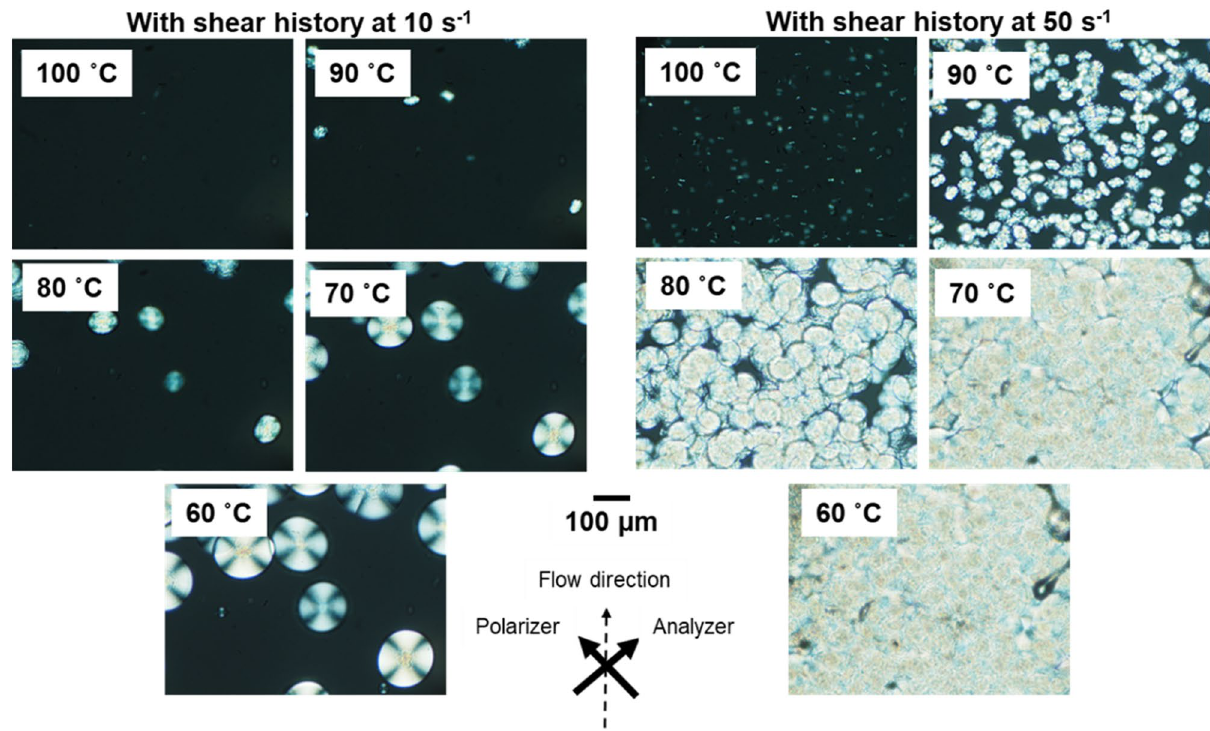
Figure 8. Polarizing optical microscope (POM) images showing the morphology of a sample. The images were obtained during cooling at shear rates of 10 and 50 s −1 . The shear history was applied from 180 to 130